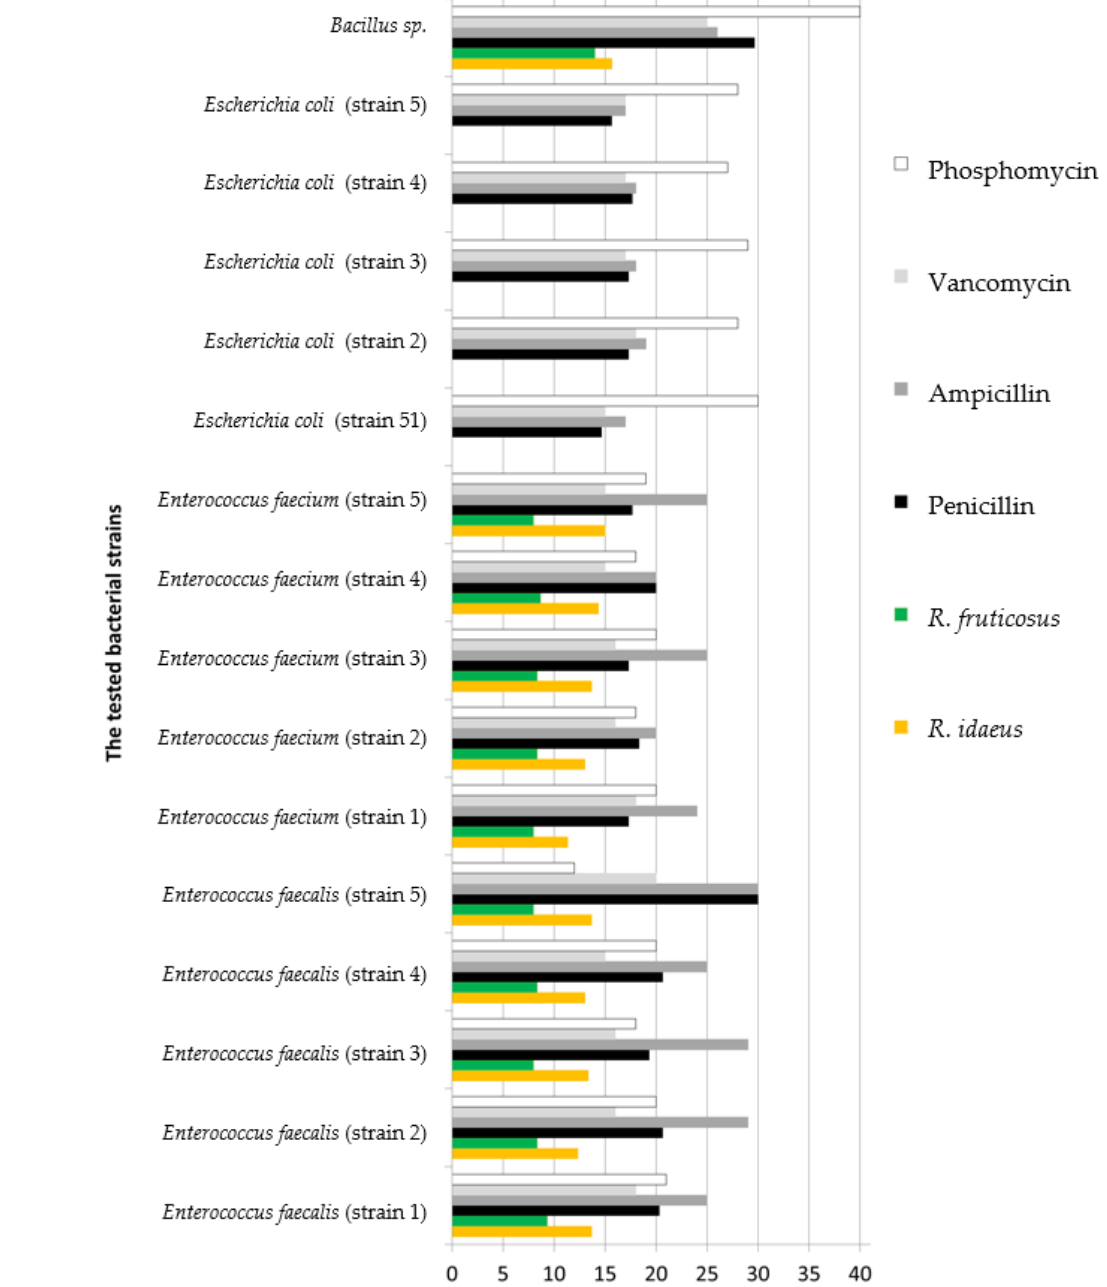
Figure 4. Interaction of P1, P2, and antibiotics with the isolated bacterial strains.